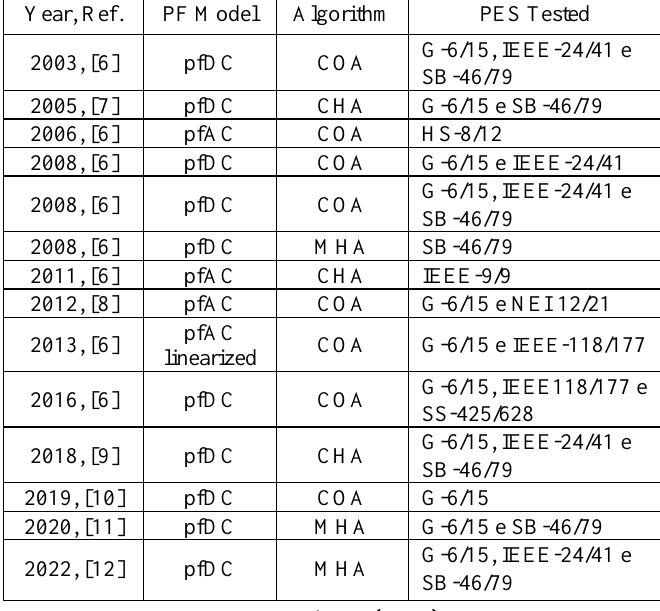
Table 2: Active power loss represented in the EC.